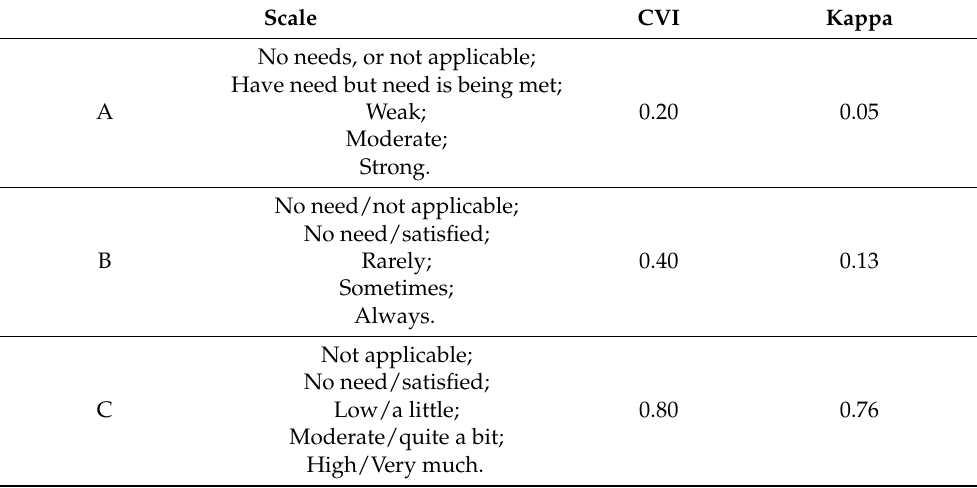
Table 2. Scale validation of the needs assessment tool for breast cancer (NeAT-BC).